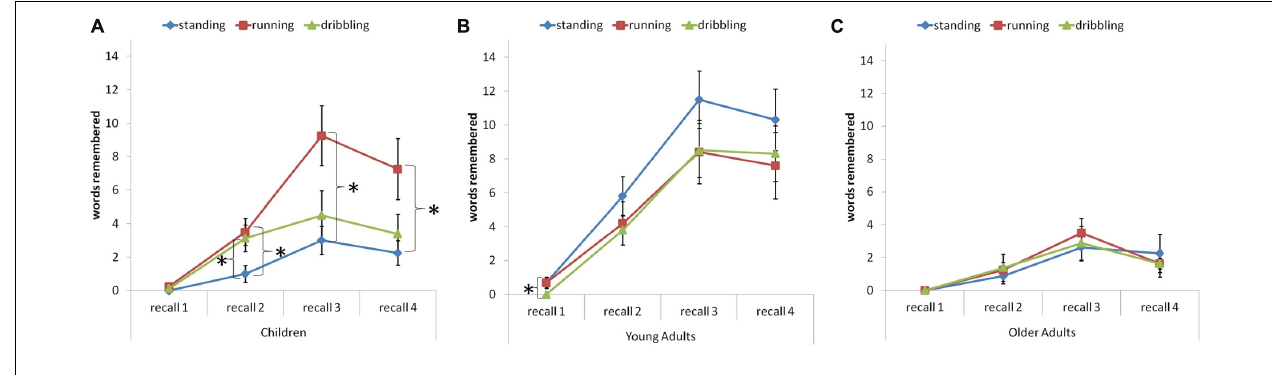
FIGURE 2 | Memory performance in the vocabulary learning task of children (A) , young adults (B) , and older adults (C) at recall test 1 to 4, in the standing, running, and dribbling conditions. Asterisks indicate results with p < 0.05. Error bars = SE means.